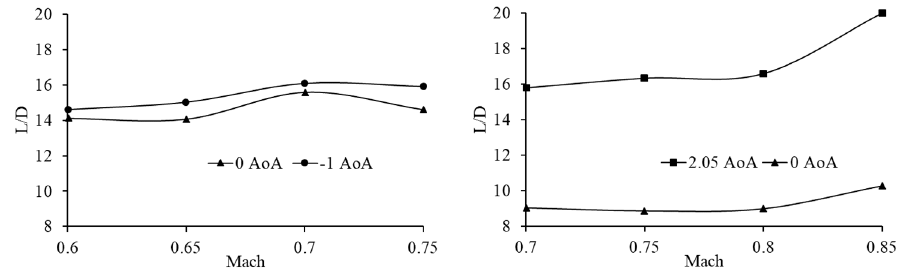
Figure 22. Lift-to-drag ratio exhibited by the BWA/SL ( left ) and CRM ( right ) aircraft, as obtained at their cruise altitude (43,000 ft and 44,000 ft, respectively) for various airspeeds and angle-of-attack